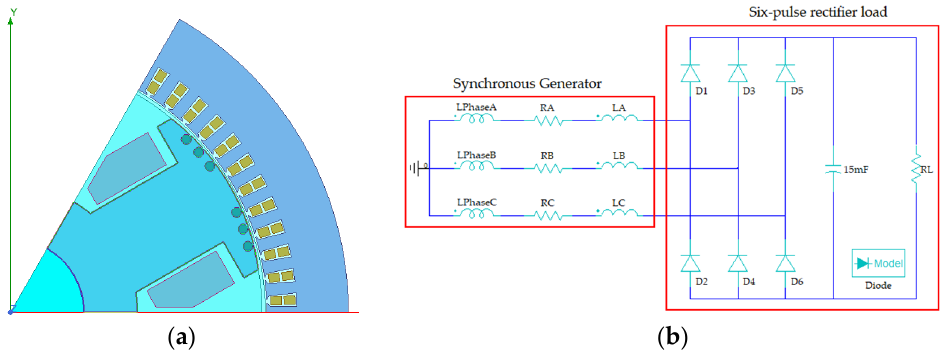
Figure 2. ( a ) Two-dimensional FE model of synchronous generator. ( b ) Coupling SG and load models within Maxwell Circuit Editor.